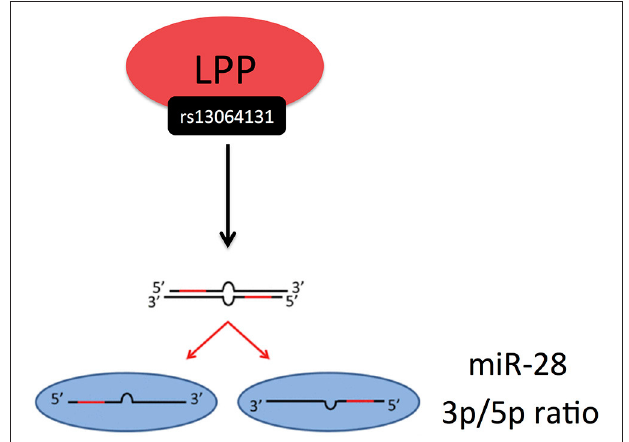
FIGURE 5 | Civelek et al. (36) demonstrated a significant association of the SNP rs13064131 with the 3p/5p ratio of miR-28, encoded from the LPP gene. The miRNA processing and strand selection was adapted from (